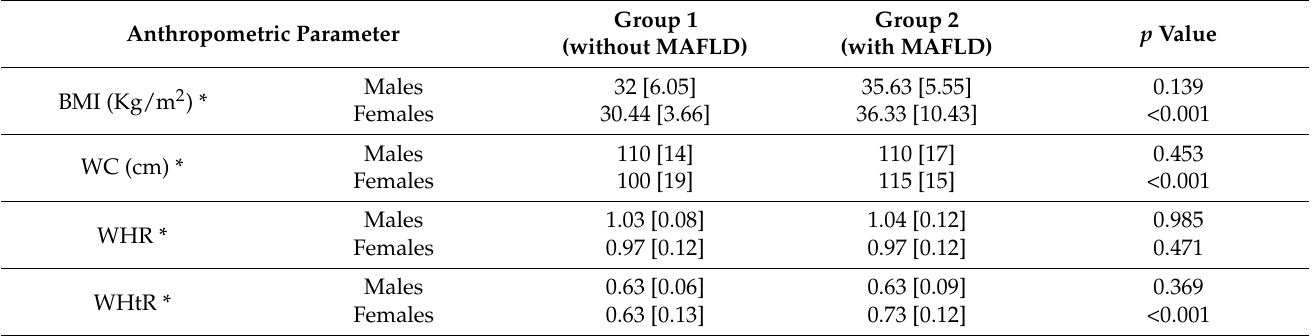
Table 1. Anthropometric parameters associated with MAFLD.